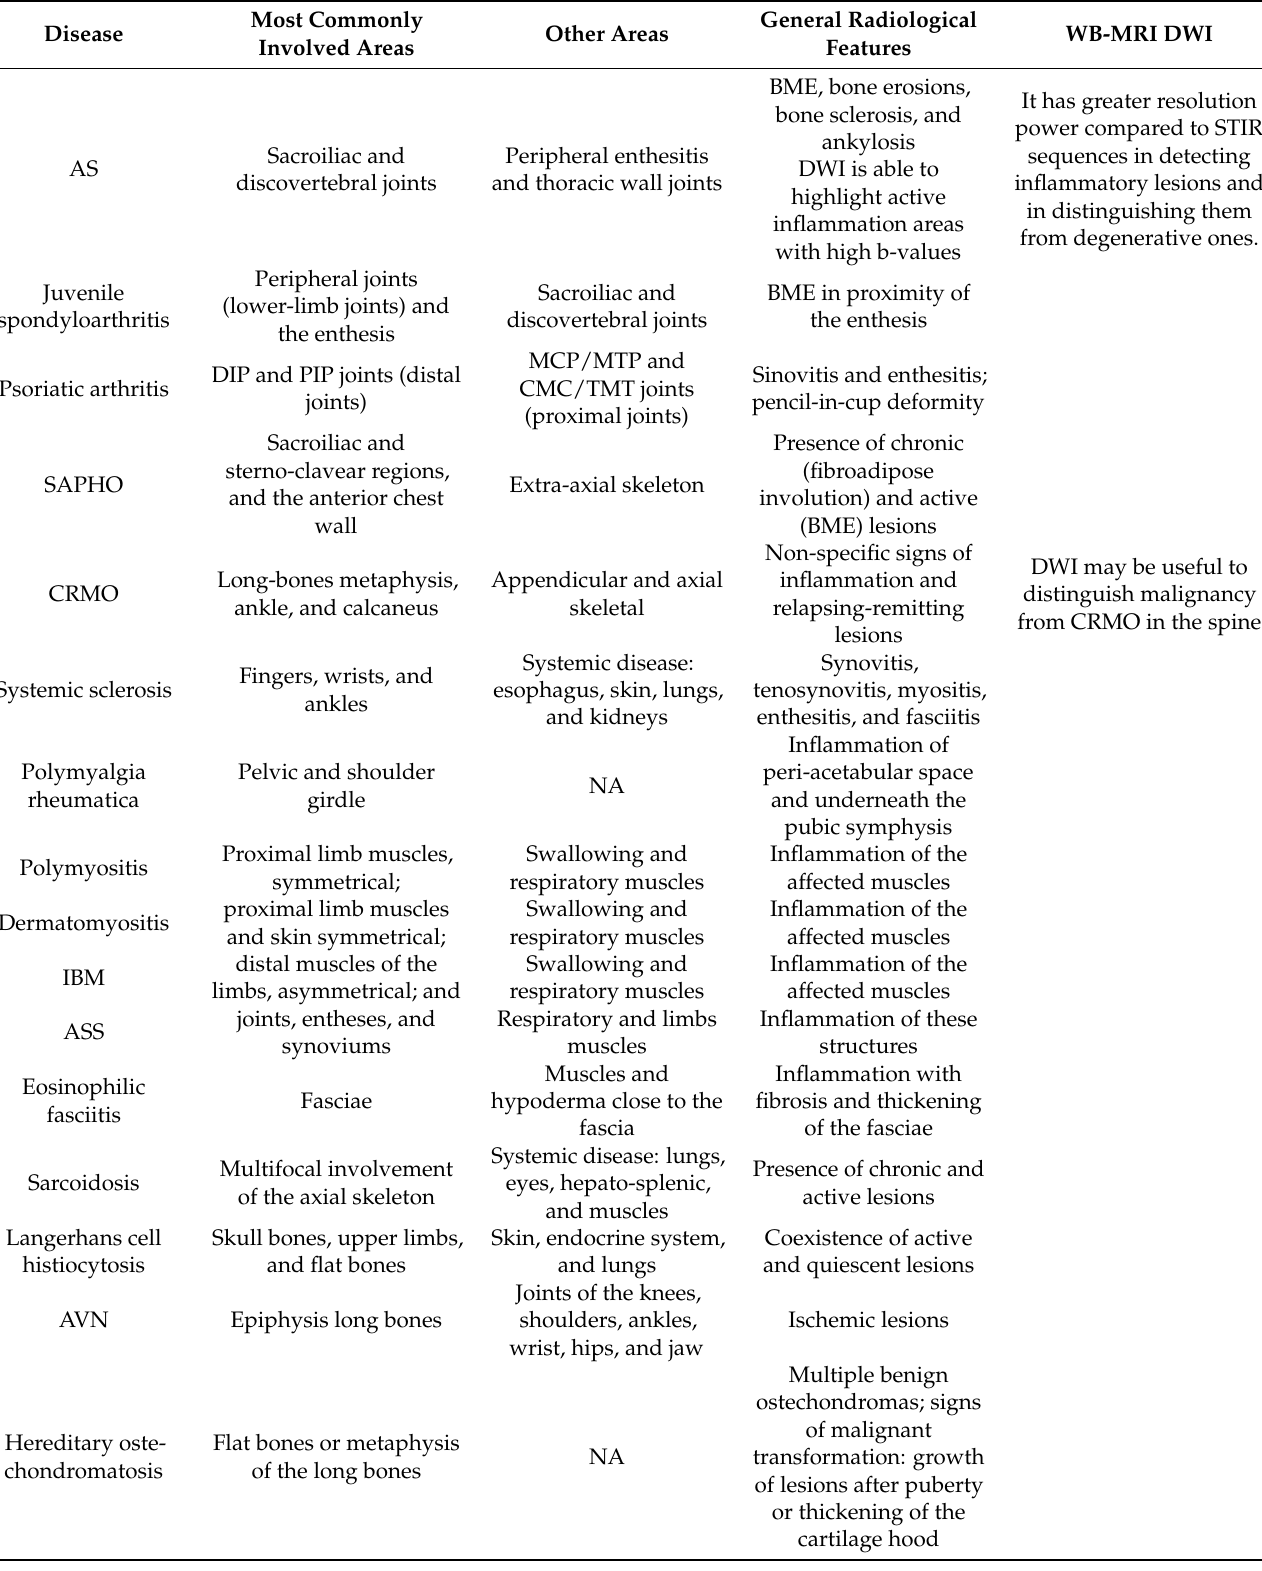
Table 1. Highlights the osteoarticular sites that are mostly affected by the main rheumatological diseases, along with other areas less commonly involved or not belonging to the musculoskeletal system. Furthermore, the main tissue alterations caused by each pathology are described, visible on the WB-MRI as zones of altered signals